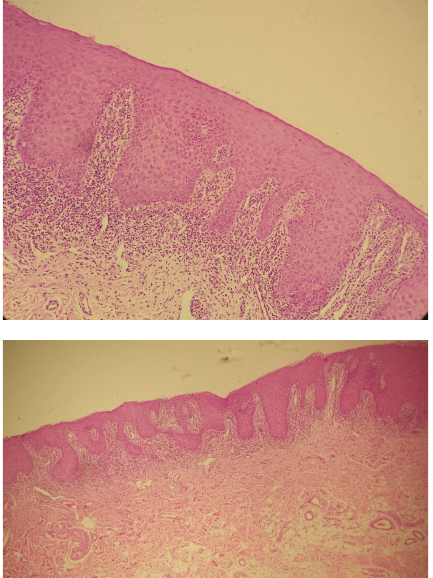
Figure2:Chronicinflammatorycellinfiltrationindermoepidermal junction in the buccal